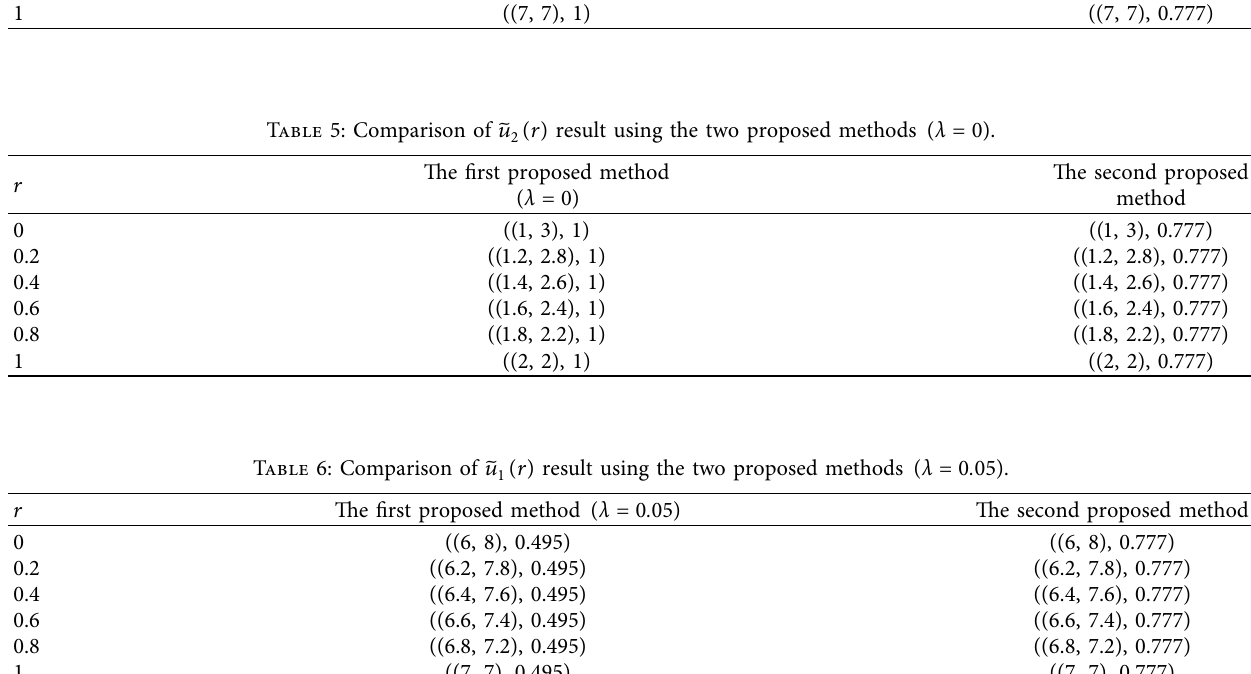
Table 4: Comparison of 􏽥 u